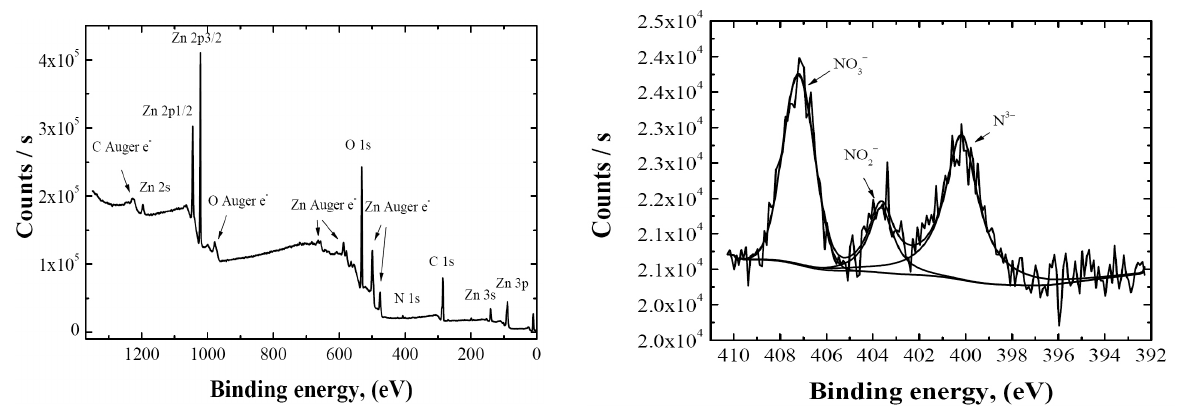
Figure 6 . XPS survey spectra of a sample treated in the 0.5 M Zn(NO ) •6H O solution for treatment time of 5 minutes. Working 3 2 2 power – 7 W, distance between the nozzle and solution level – 3 mm.